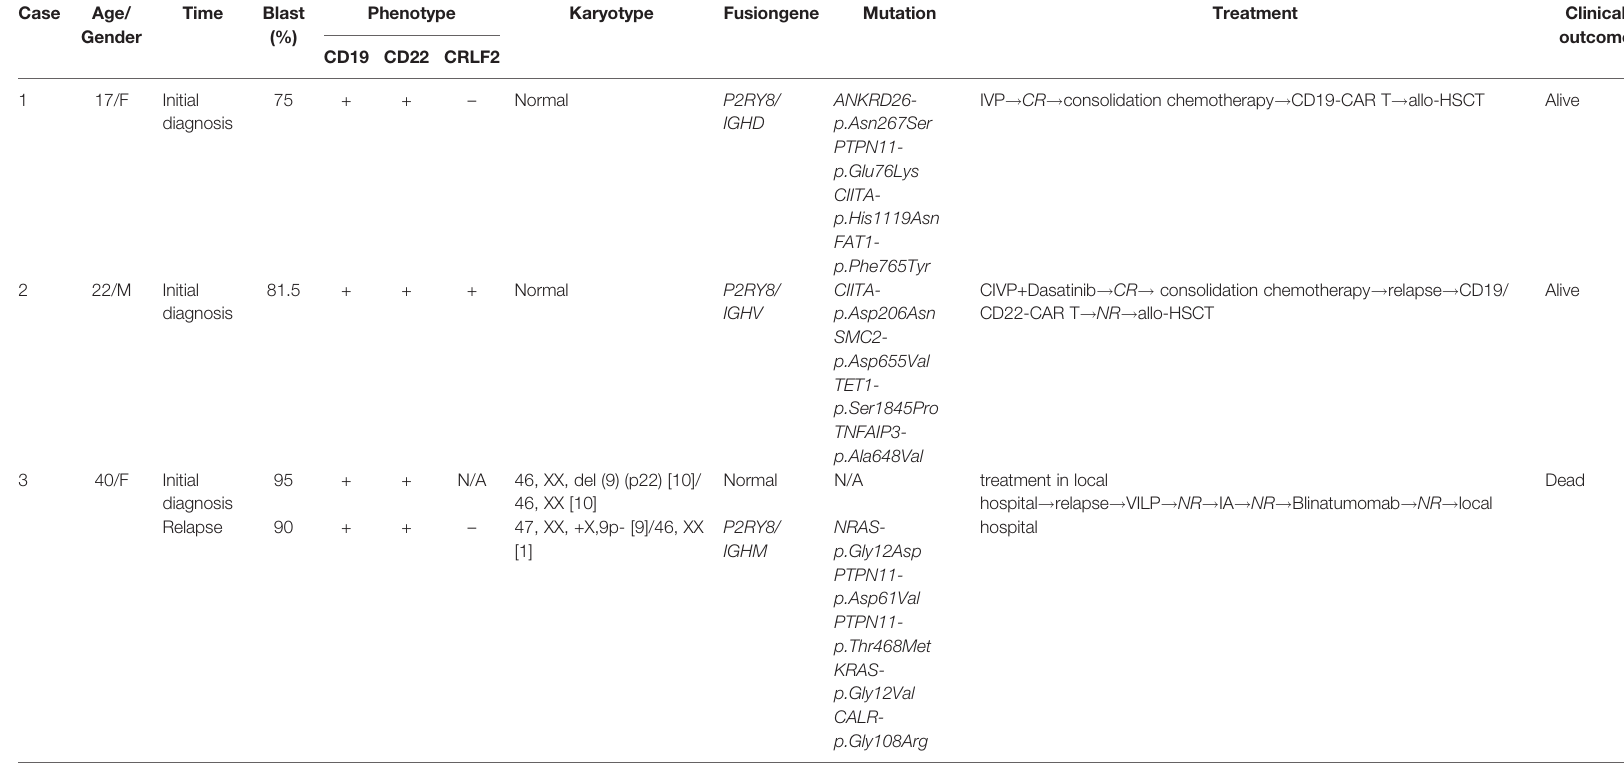
TABLE 1 | Patient characteristics and clinical